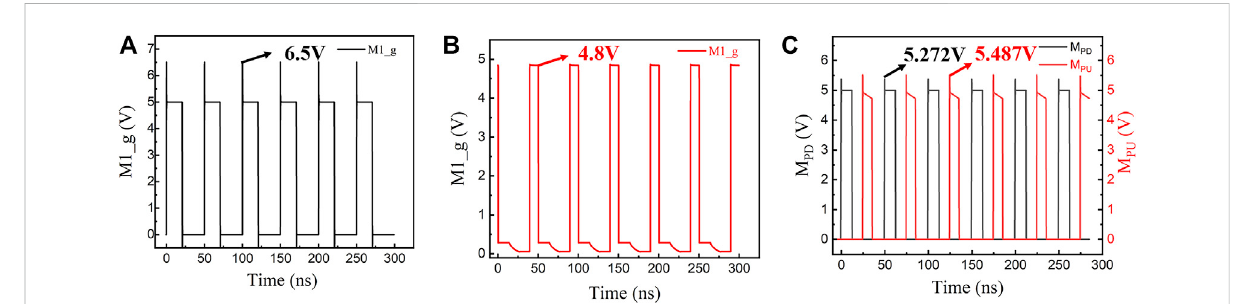
Simulation results comparing the proposed structure and conventional capacitor-discharge resonant driver circuit waveforms: (A) conventionalcapacitor-dischargeresonantdriverwaveformoftheM